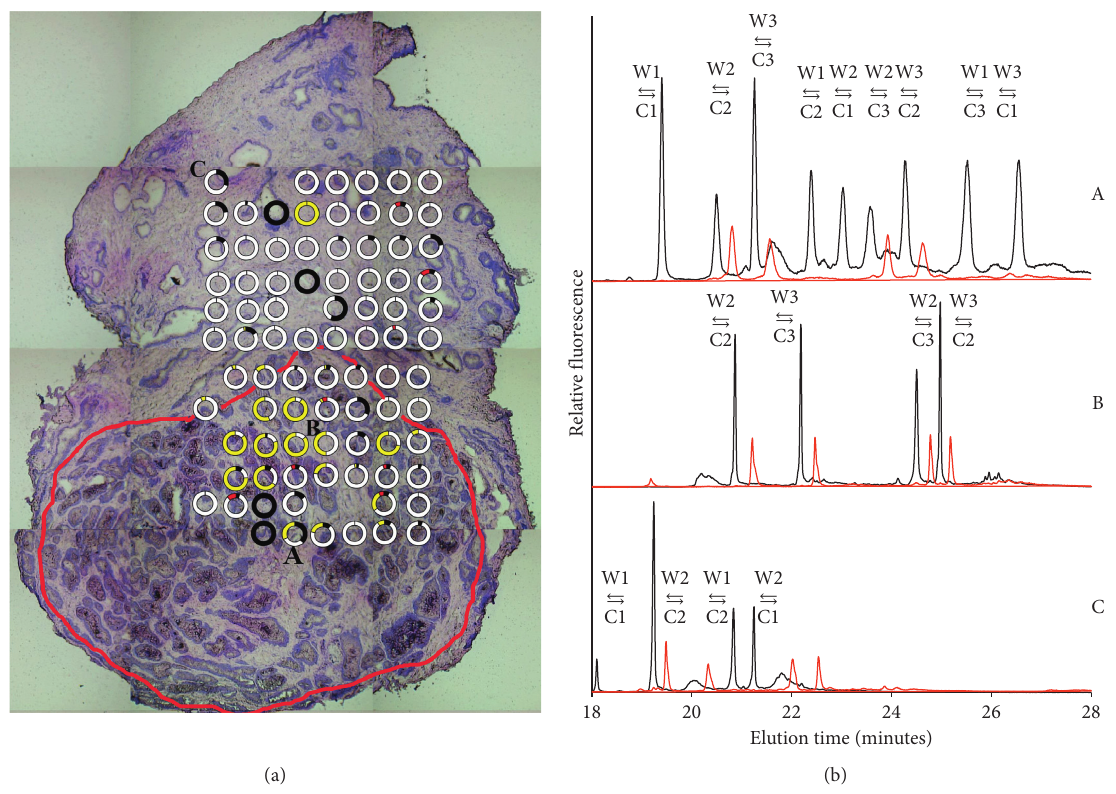
Figure 3: (a) Giemsa stained slice from prostate no. 3, sample 5, transposed mutant fractions obtained by focused laser capture mi- crodissection in a grid of 8 × 12 spots. The red line encircles the tumor as defined by an experienced uropathologist. The circles in (a) show the LCM dissected areas and positions. White represents wild type or homoplasmy. The colors reflect the mutant fractions and their combinations. Corresponding electropherograms for the three circles labeled (A), (B), and (C) are reproduced in (b). (b) Electropherograms related to detected mtDNA mutations, their fractions, and combinations. The red signal represents a fragment specific internal standard used as a reference. Electropherogram (A) reflects mtDNA mutational combinations in the collected spot above the letter (A). Elec- tropherogram (B) reflects mtDNA mutational combinations in the collected spot to the below-right of the letter (B). Electropherogram (C) reflects mtDNA mutational combinations in the collected spot to the below-right of the letter